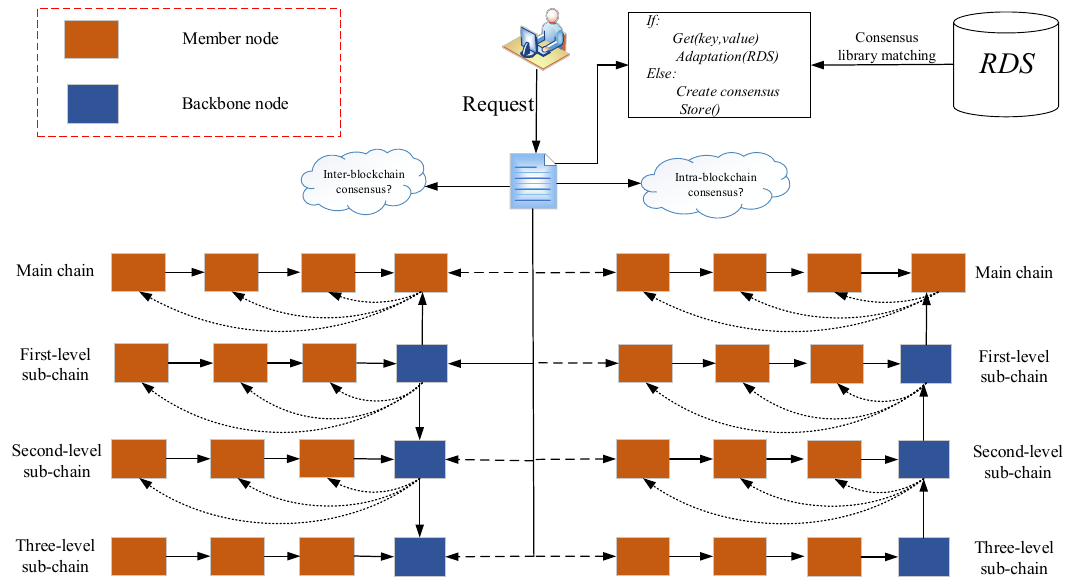
Figure 6. Schematic diagram of hierarchical consensus mechanism.